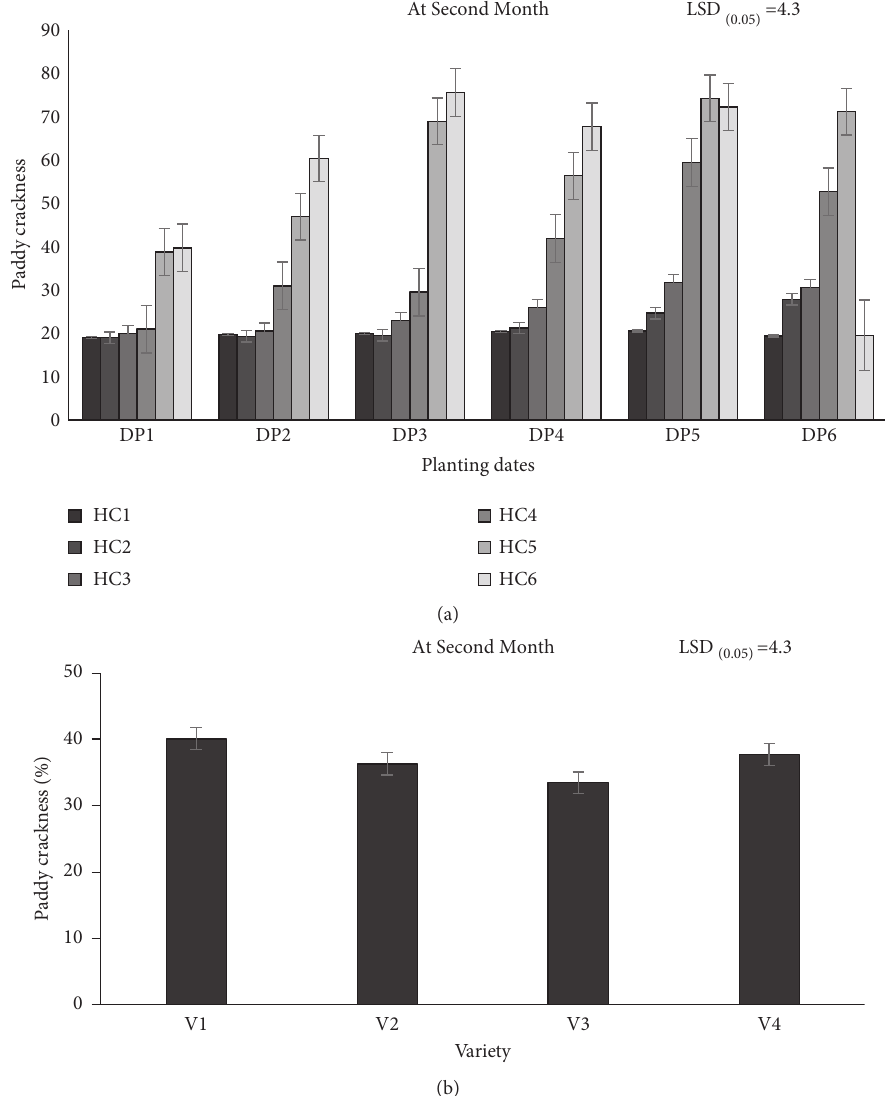
Figure 6: (a) Effect of planting date and harvest cycle on paddy crackness at two months of storage in the Northern Savanna Agroecological Zone of Ghana. Bars represent the SEM. (b) Effect of perfumed rice varieties on paddy crackness at two months of storage in the Northern Savanna Agroecological Zone of Ghana. Bars represent the SEM. DP1 � first planting, DP2 � second planting, DP3 � third planting, DP4 � fourth planting, DP5 � fifth planting, DP6 � sixth planting, V1 � Agra, V2 � Gbewaa, V3 � Exbaika, V4 � Perfume Irrigated, HC1 � first harvest, HC2 � second harvest, HC3 � third harvest, HC4 � fourth harvest, HC5 � fifth harvest, and HC6 � sixth